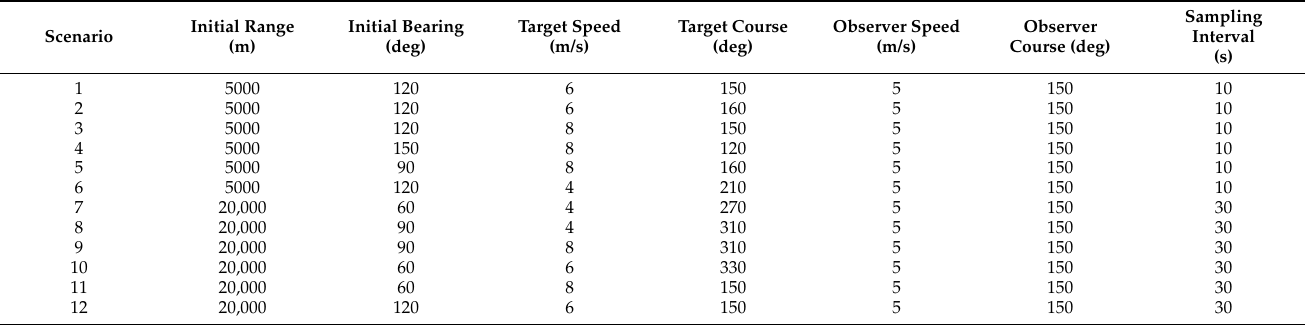
Table 1. Scenarios of underwater target at close range used for performance